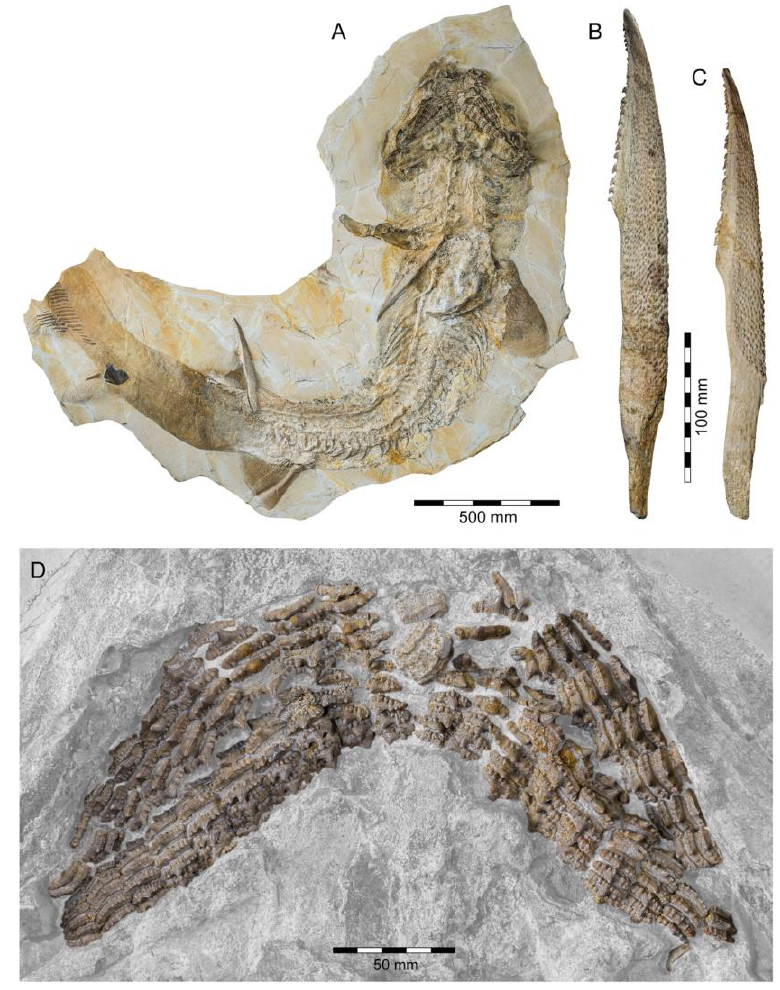
Figure 11. Specimen of † Asteracanthus ornatissimus Agassiz, 1837 [171] from the lower Titho- nian of Solnhofen. ( A ) Complete specimen (PBP-SOL-8003). Close-up view of ( B ) anterior and ( C ) posterior dorsal fin spine. ( D )